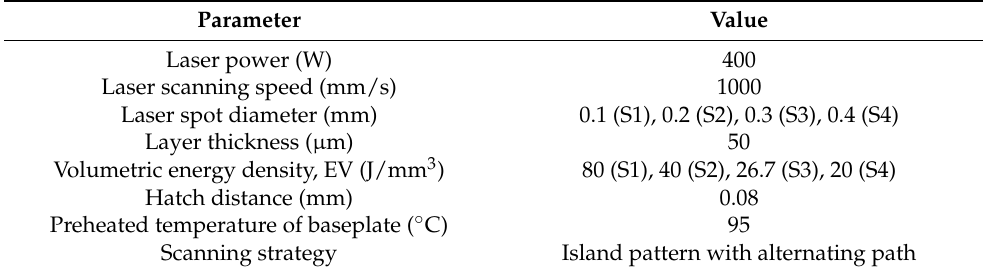
Table 1. SLM process parameters for fabricating tensile test